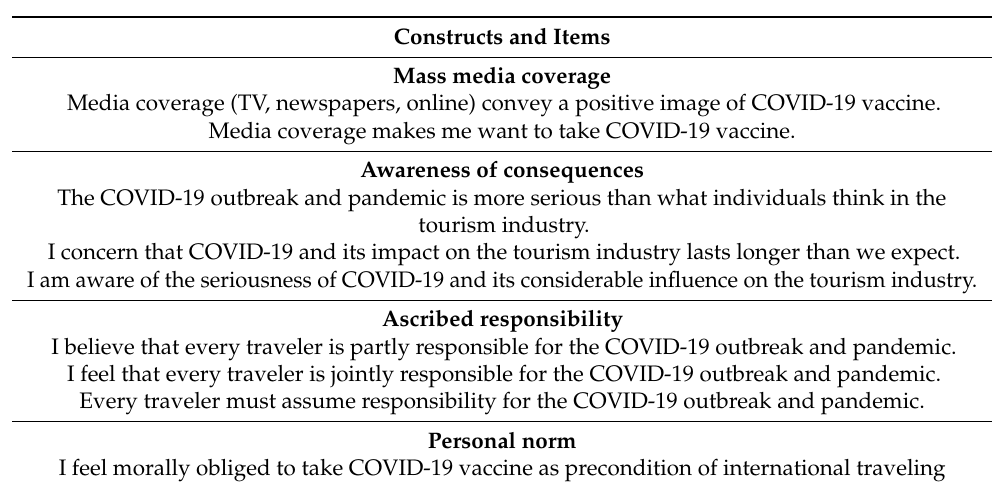
Table A1. Constructs and Measurement